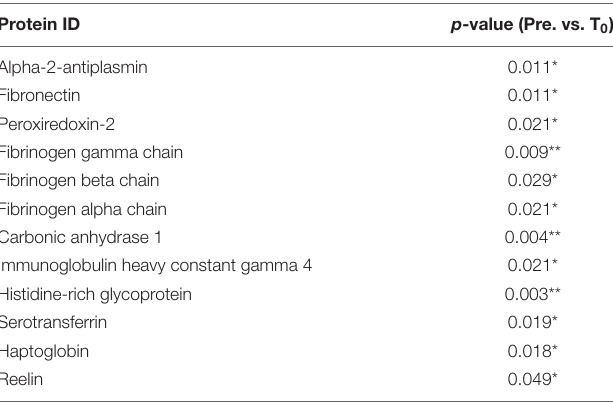
TABLE 2 | EV proteins significantly elevated at T 0 .